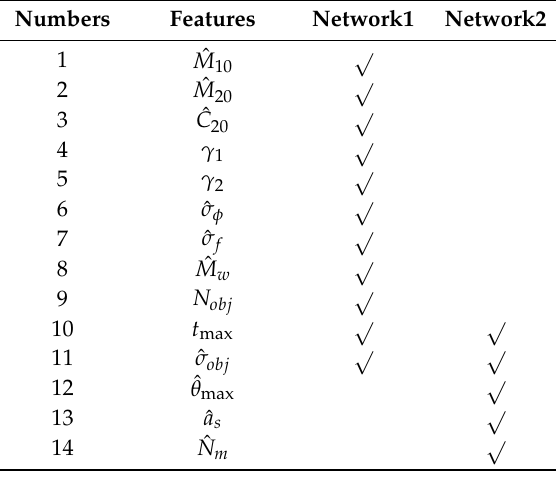
Table 3. Features of network1 and